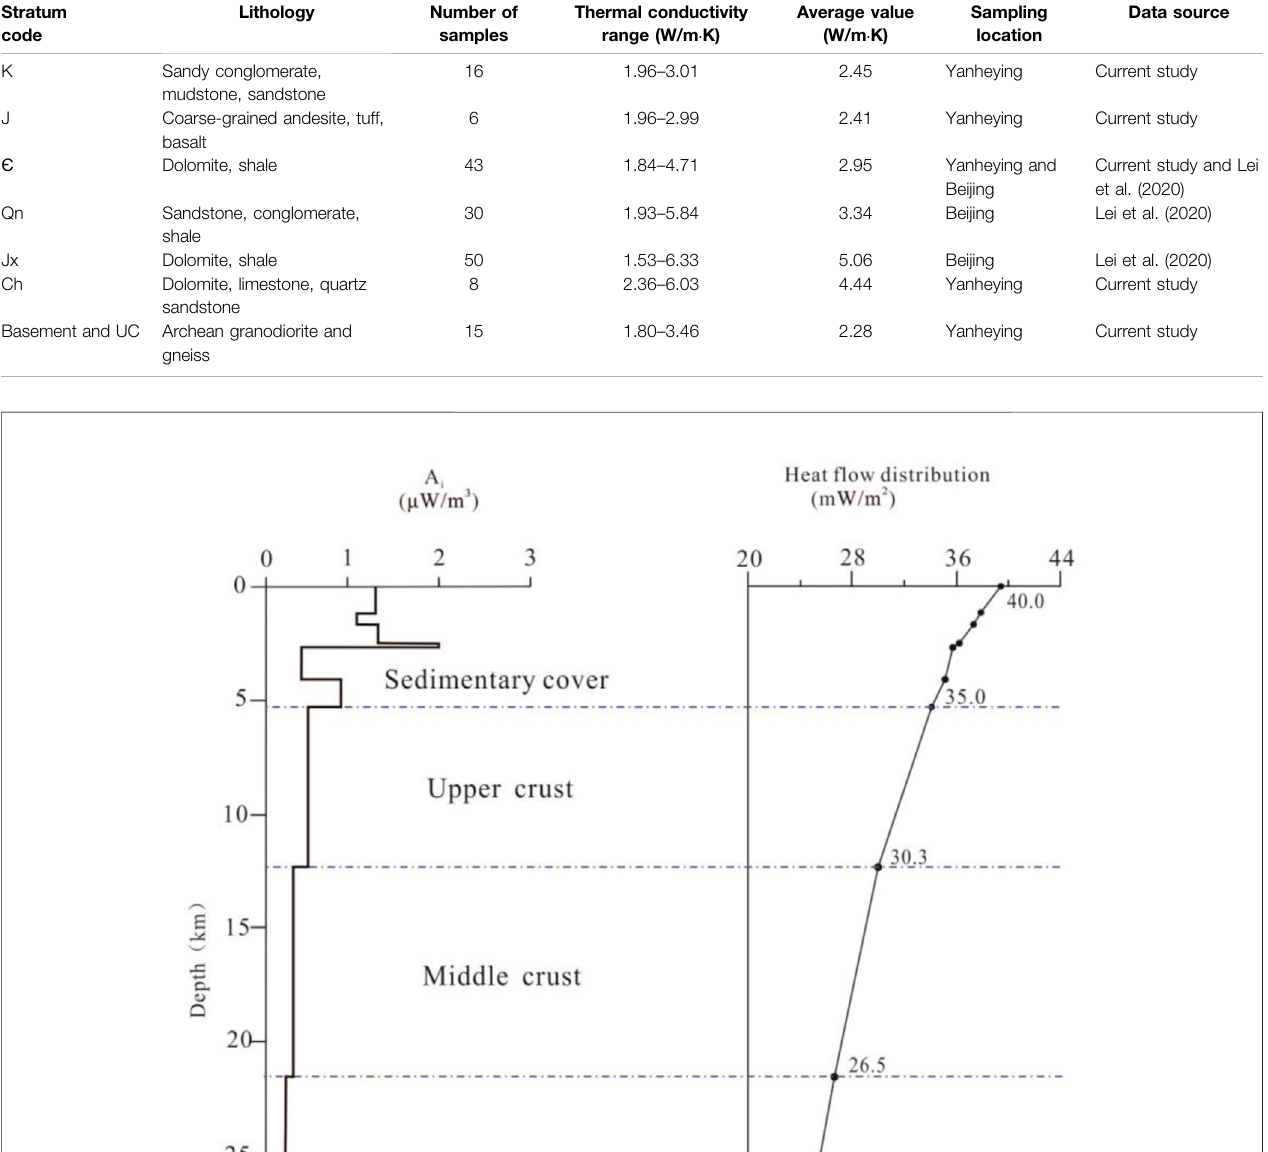
TABLE 4 | Thermal conductivity of the Yanheying Basin and surrounding pre-Cenozoic